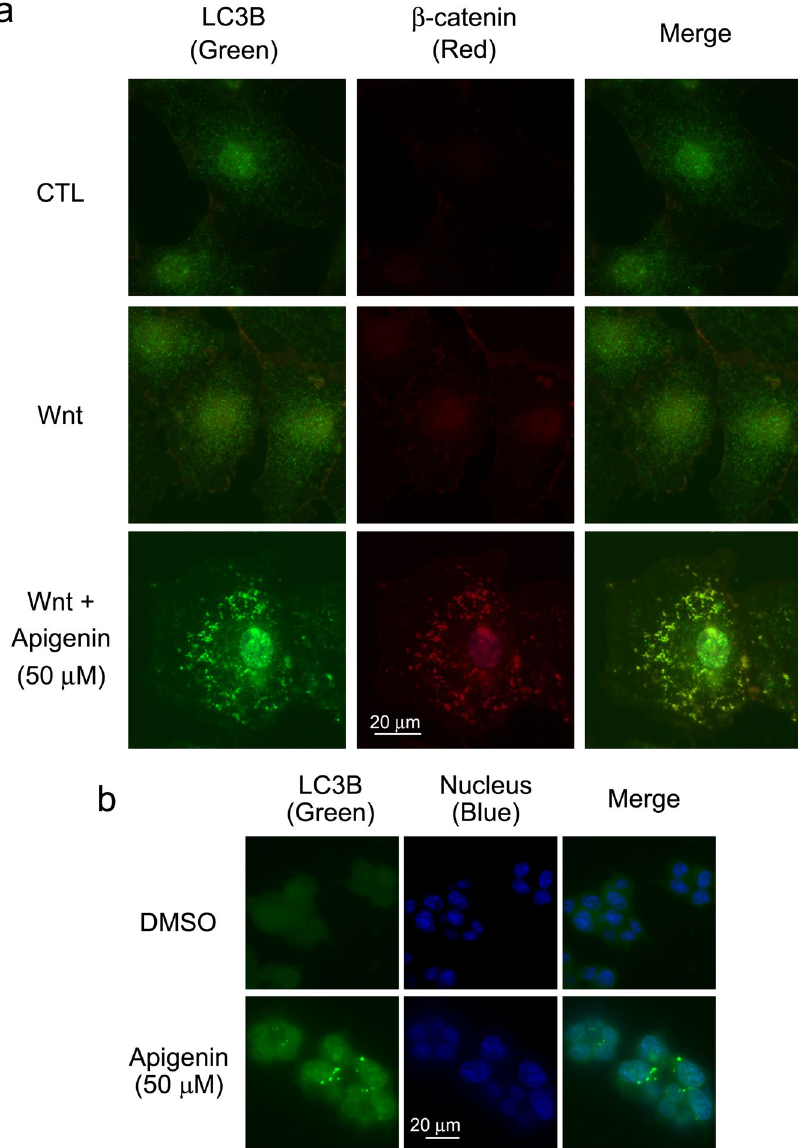
Figure 7. Apigenin induces the formation of autophagosomes in cells. ( a ) Apigenin induces the formation of autophagosomes in Wnt-stimulated COS-7 cells. COS-7 cells were treated with control-conditioned medium (CTL), Wnt-3a-conditioned medium (Wnt), or 50 μ M of apigenin in Wnt-3a-conditioned medium (Wnt + 50 μ M Apigenin) for 20 h, and cells were processed for immunofluorescent staining with LC3B antibody (labeled in green) and β -catenin antibody (labeled in red). ( b ) Apigenin induces the formation autophagosomes in Wnt-driven HCT-116 cells. Cells were treated with carrier reagent (DMSO) or 50 μ M of apigenin for 22 h and processed for immunofluorescent staining with LC3B antibody (labeled in green). Cell nuclei were stained with DAPI (labeled in